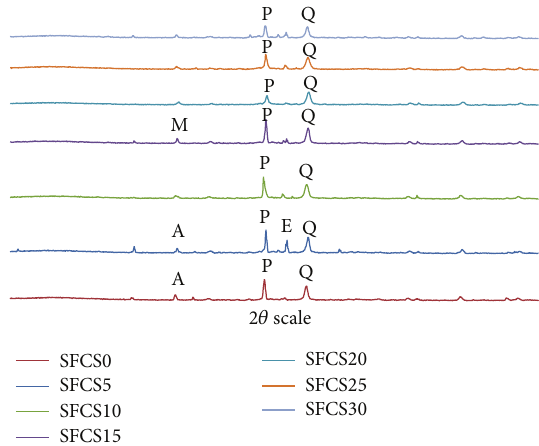
Figure 9: XRD analysis result in 2 𝜃 scale. P: portlandite; Q: quartz; A: aluminosilicate; E: ettrignite; M: